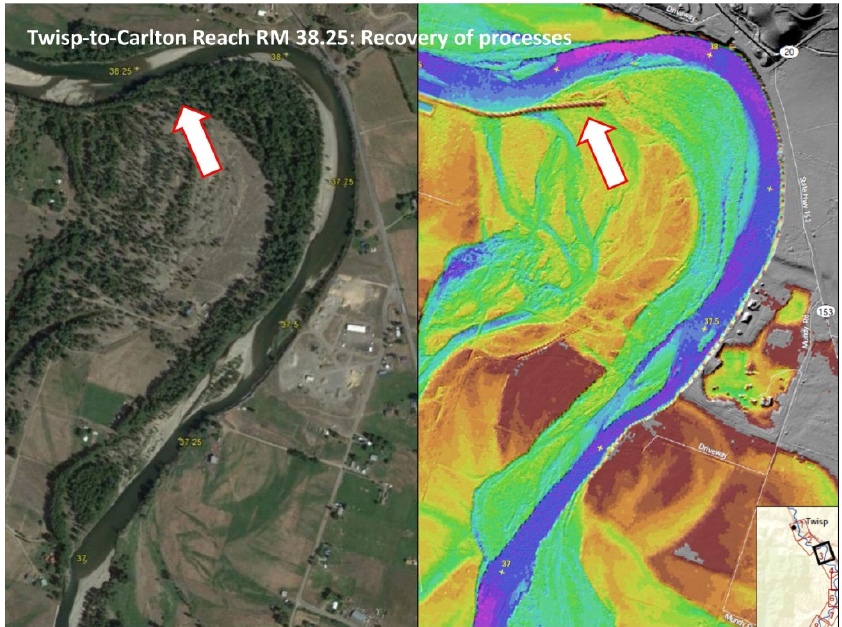
Figure 7. Location of the levee (arrow in both frames) that presently blocks the reoccupation of an extensive side-channel network. Numbers along the channel are river miles; flow is from the upper left to the bottom of the images. Left panel: air photo view (from Google Earth). Right panel: colors show ground elevation relative to the adjacent low-water surface elevation using a LiDAR-generated digital elevation model: deep blue = <0.3 m, turquoise/green = 0.3–2 m, yellow = 2–3 m, tan/brown = 3–4 m, gray >4 m.